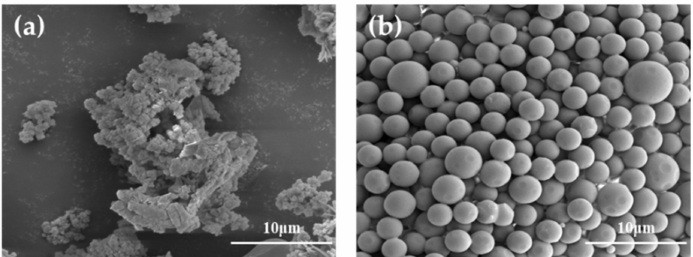
Figure 7. SEM image of polymer shape with and without oxygen: ( a ) composite image of polymer exposed to oxygen, and ( b ) composite image of polymer produced by blocking